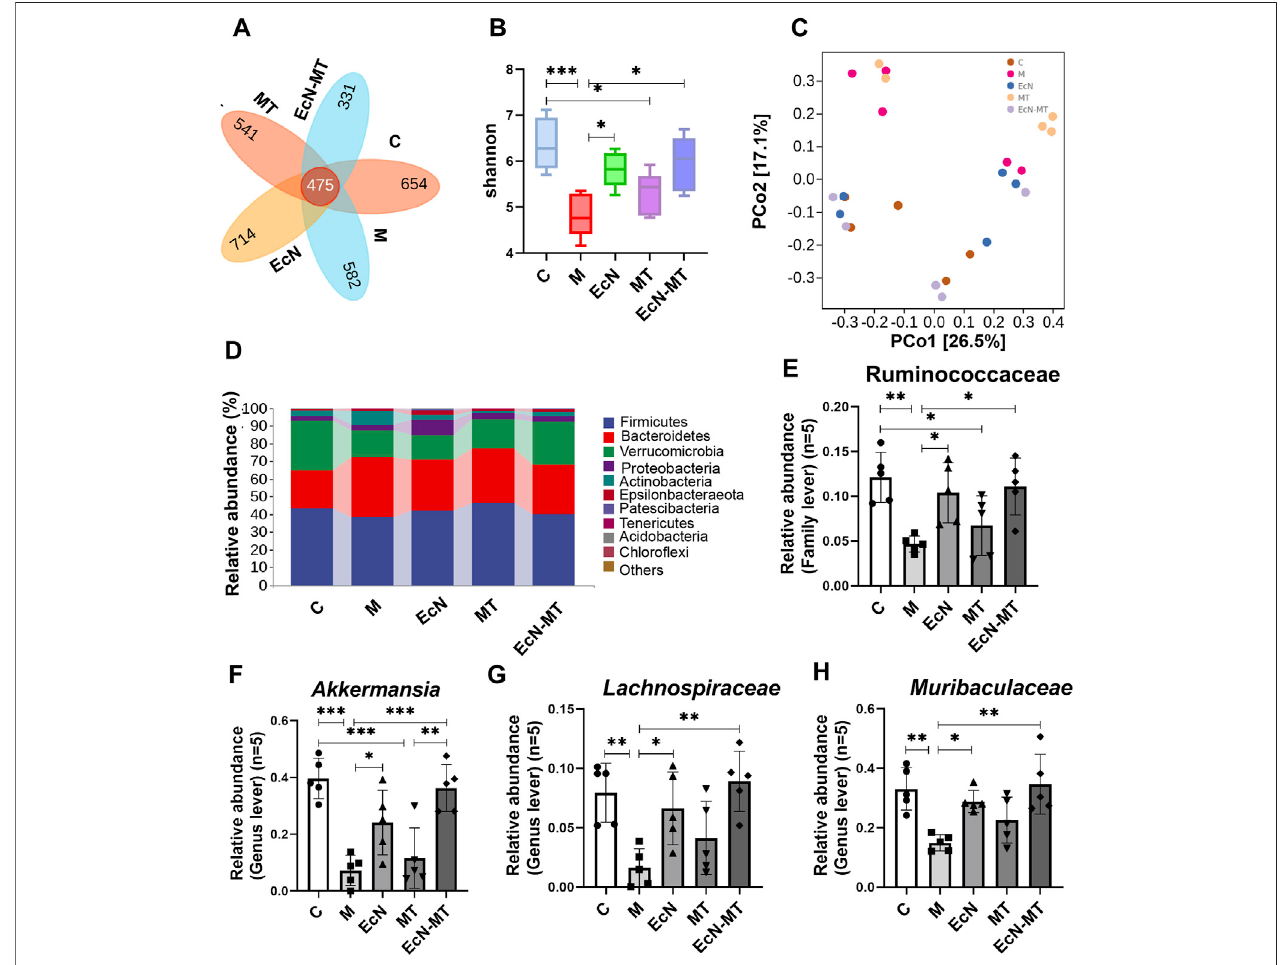
FIGURE4 | EcN-MT improved intestinal microbiota in subchronic Cd-exposed mice. Values are presented asmeans ±SD ( n = 5). (A) Venn map representation of OTUs. (B) The Shannon index. (C) PCoA of β diversity index. (D) Microbial composition at the phyla level. The relative abundance of (E) Ruminococcaceae,